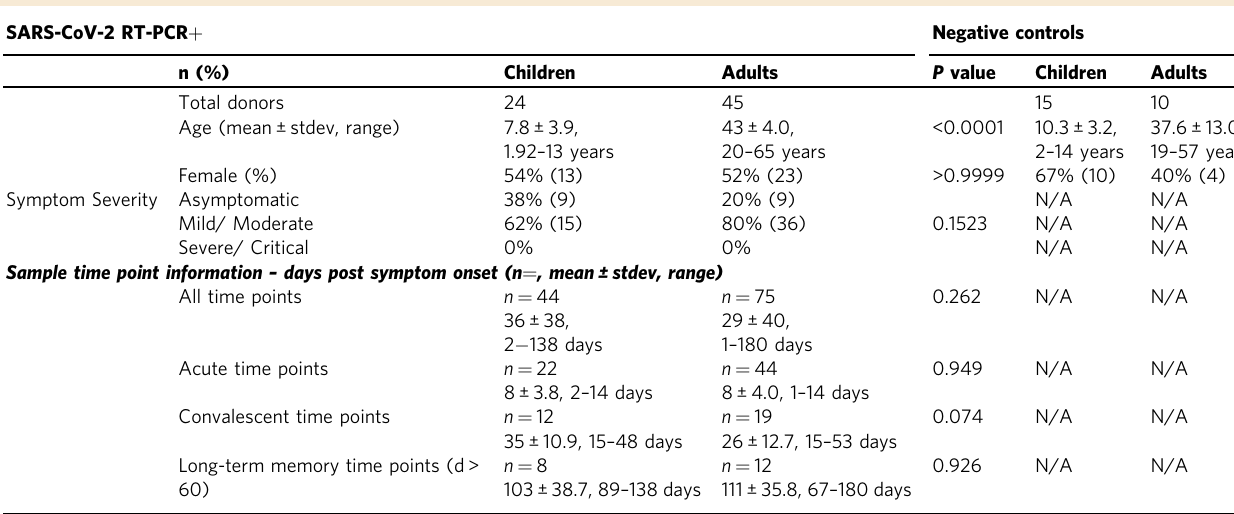
Table 1 Summary of cohort